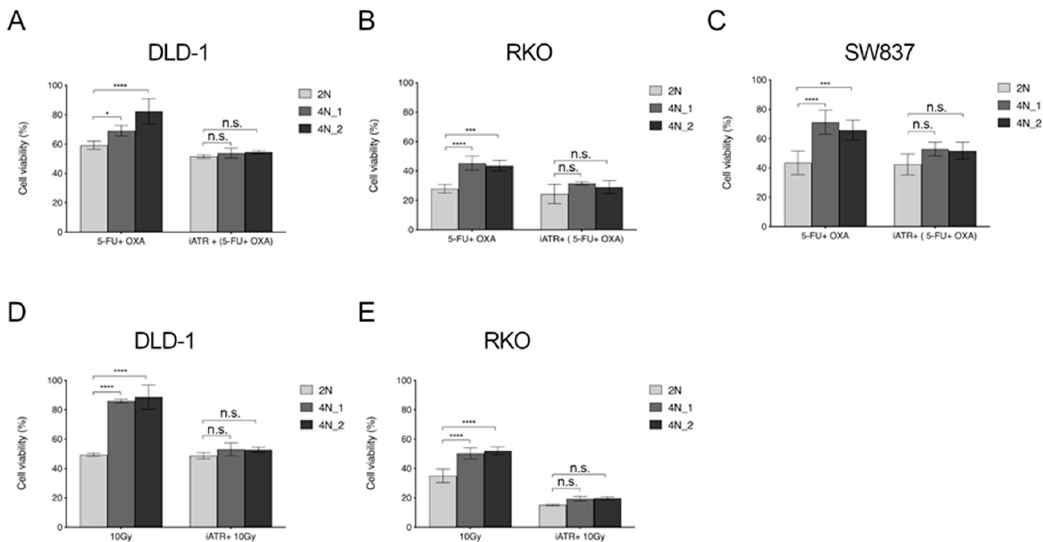
Figure 6. Effect of FOLFOX and ionizing radiation upon treatment of 2N and 4N cells with the ATR inhibitor VE-821. Histograms showing cell viability in response to VE-821 treatment prior to FOLFOX treatment ( A – C ) or ionizing radiation ( D – E ). One 2N and two 4N clones of ( A ) DLD-1, ( B ) RKO and ( C ) SW837 were treated with FOLFOX (25 µM 5-fluorouracil and 20 µM oxaliplatin) for 72 h, when indicated 10 µM VE-821 was added for 24 h prior to FOLFOX treatment. Same clones of ( D ) DLD-1 and ( E ) RKO were irradiated with a dose of 10 Gy, 10 µM VE-821 was added for 24 h before irradiation when indicated. Each cellular viability was normalized based on its corresponding non-treated or non-irradiated counterpart. Mean of at least three independent experiments with SD is shown. n.s., not significant; *, p < 0.05; ***, p < 0.001; ****, p < 0.0001.